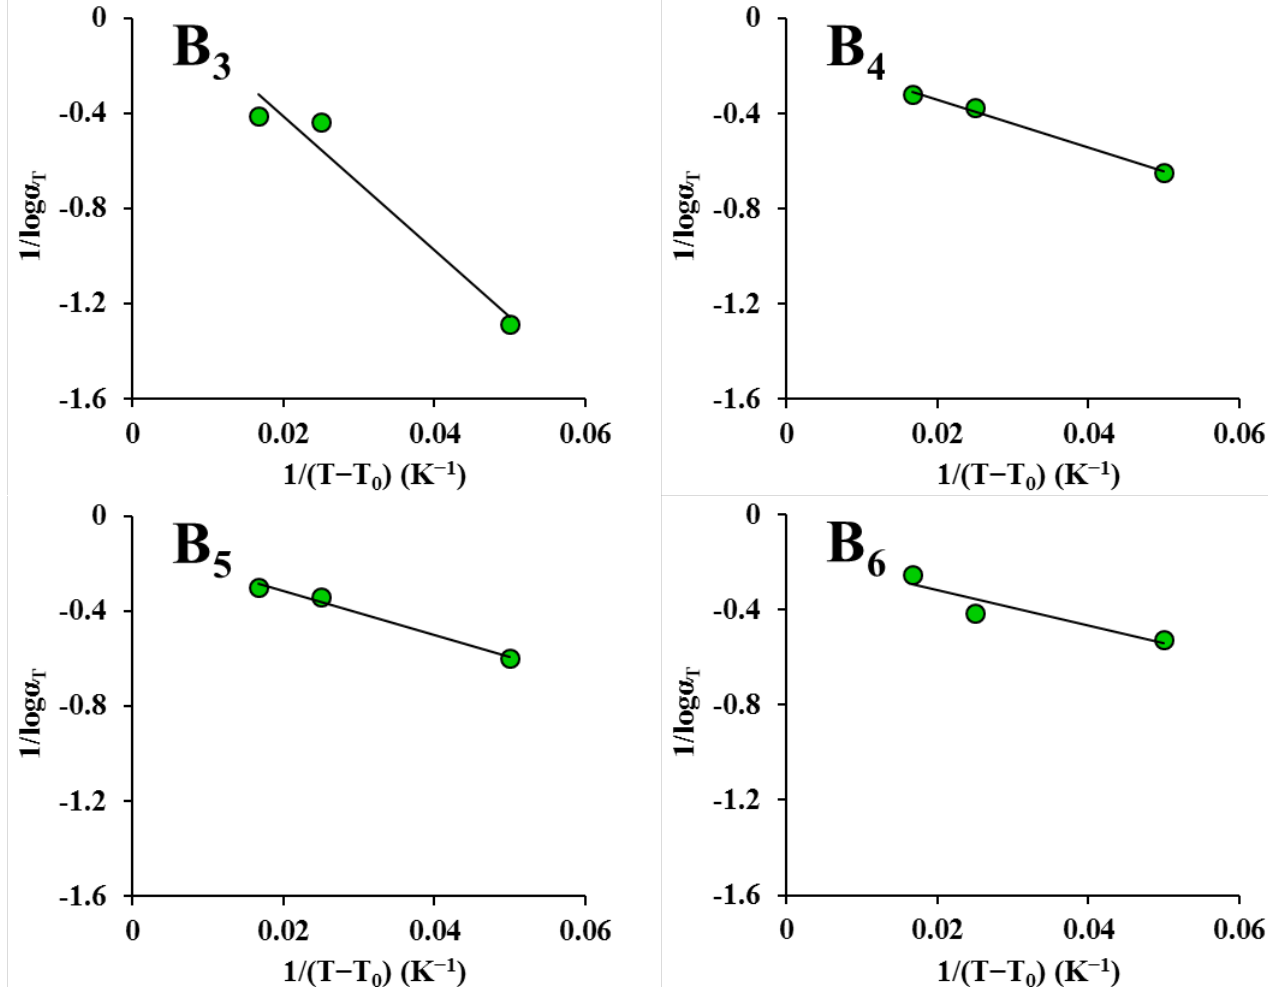
Figure 5. Shift factors fitted to the Arrhenius equation for maize kernels (stress relaxation): ( A 1 ) ND; ( A 2 ) HVD 35 °C; ( A 3 ) HVD 45 °C; ( A 4 ) HVD 55 °C; ( A 5 ) HVD 65 °C; ( A 6 ) HVD 75 °C. Shift factors fitted to the William–Landel–Ferry (WLF) equation for maize kernels (stress relaxation): ( B 1 ) ND; ( B 2 ) HVD 35 °C; ( B 3 ) HVD 45 °C; ( B 4 ) HVD 55 °C; ( B 5 ) HVD 65 °C; ( B 6 ) HVD 75 °C.